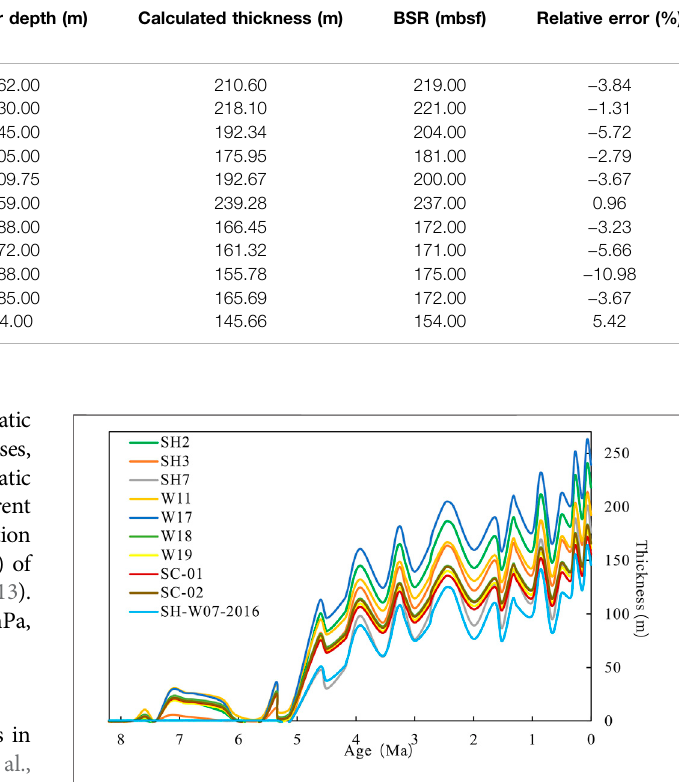
FIGURE 3 | The thickness change in the GHSZ at different single sites since 8.2